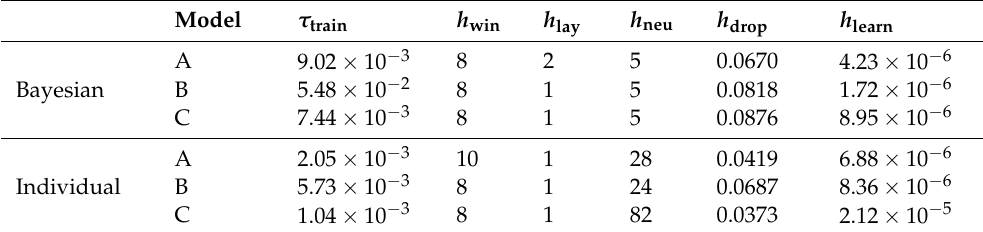
Table 1. Hyperparameter results. The table shows the hyperparameter configuration for the hyperpa- rameters h win , h lay , h neu , h drop and h learn for each model. The “Bayesian” area shows the arithmetic mean of two results with the same hyperparameter configuration and “Individual” area shows the results for each individual model.